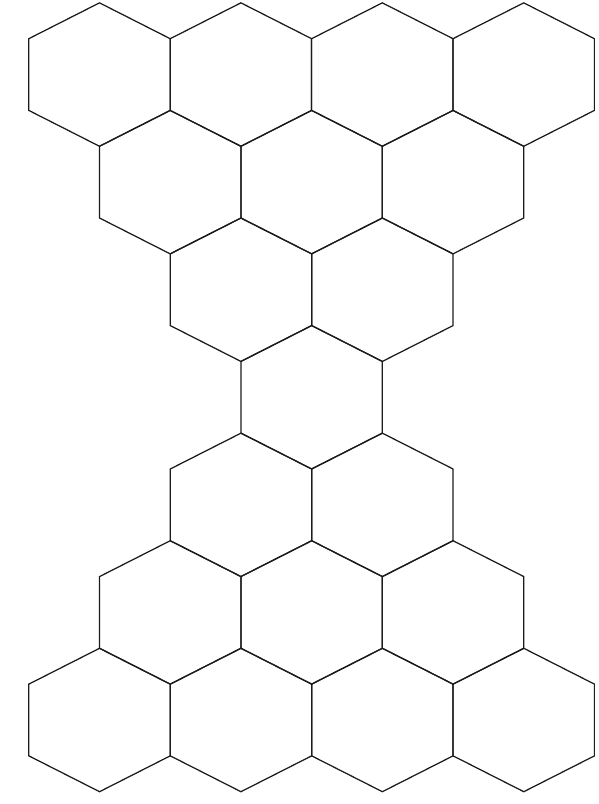
Figure 2: Benzenoid hourglass